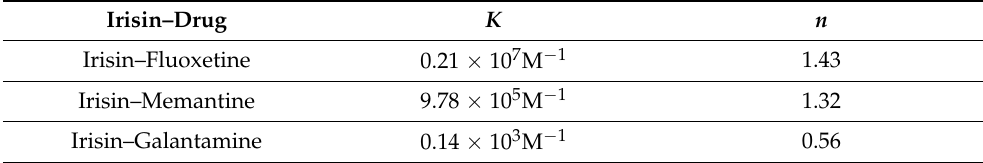
Table 2. Binding parameters obtained from double logarithmic equation.